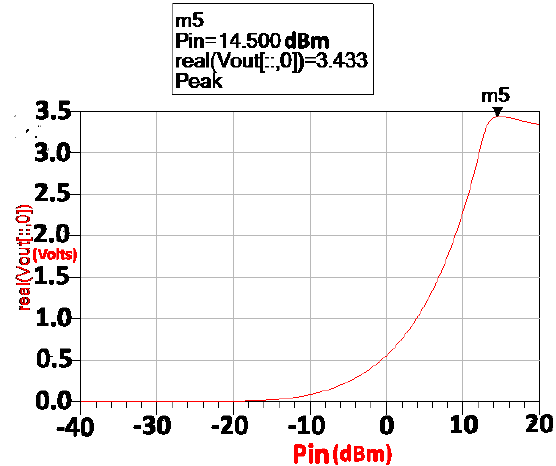
Figure 10: Output Voltage across load resistance of 1